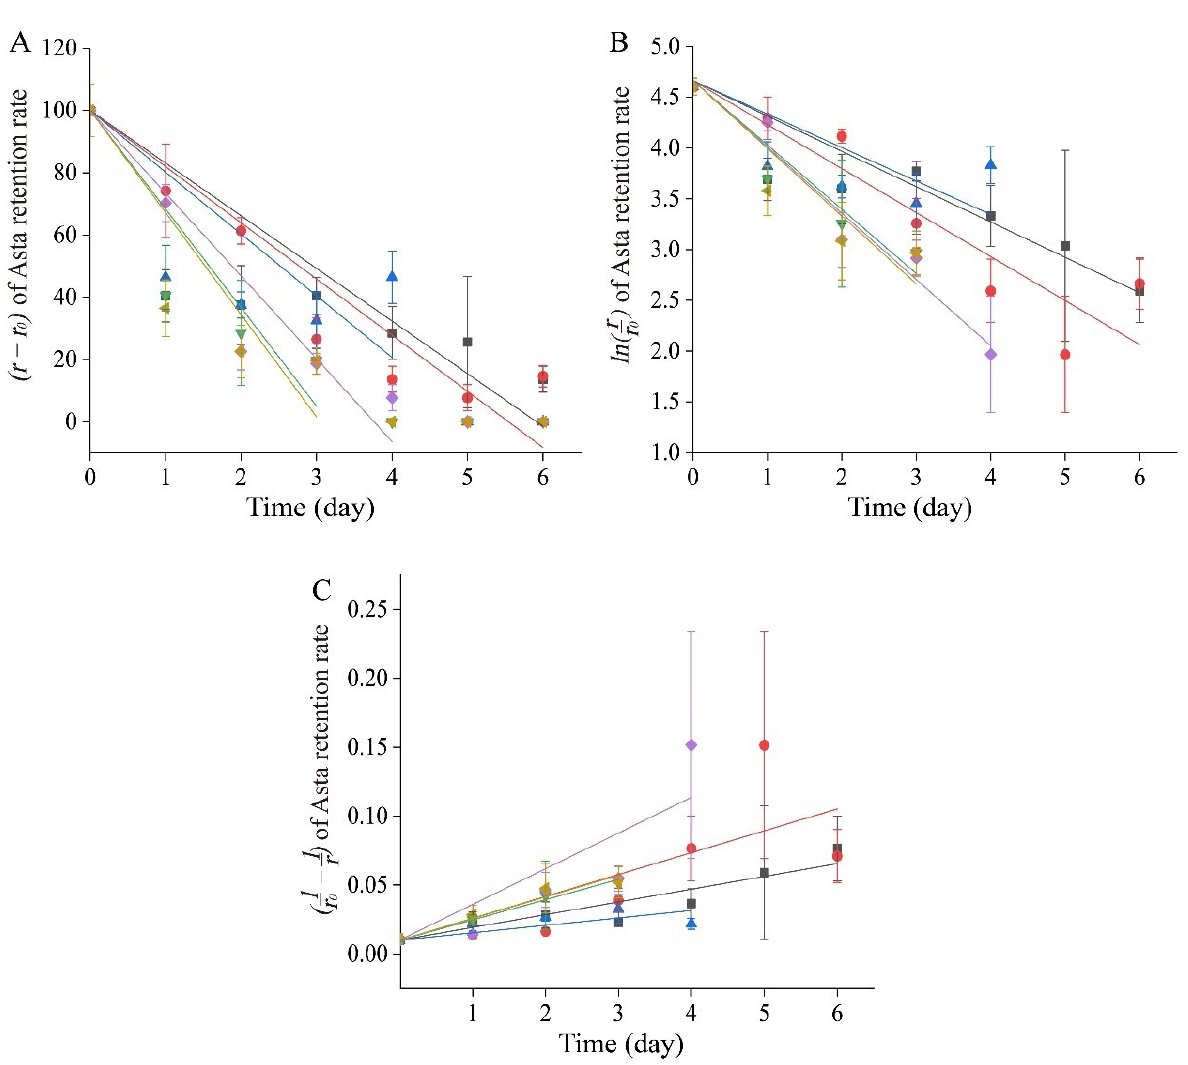
Figure 7. Degradation kinetics of Asta in APEs under conditions of pH 3.0 ( ■ ) , pH 5.0 ( ● ), pH 7.0 ( ▲ ), pH 9.0 ( ▼ ), Na + ( ◆ ), and K + ( ◄ ), respectively. ( A ) Zero order kinetics; ( B ) first order kinetics; and ( C ) second order kinetics. All data were expressed as the mean ± standard deviation ( n = 3). Table 2. Degradation kinetics parameters of k (rate constant) and R 2 (determination coefficients), t 1/2 (half-life periods) of Asta in APEs.